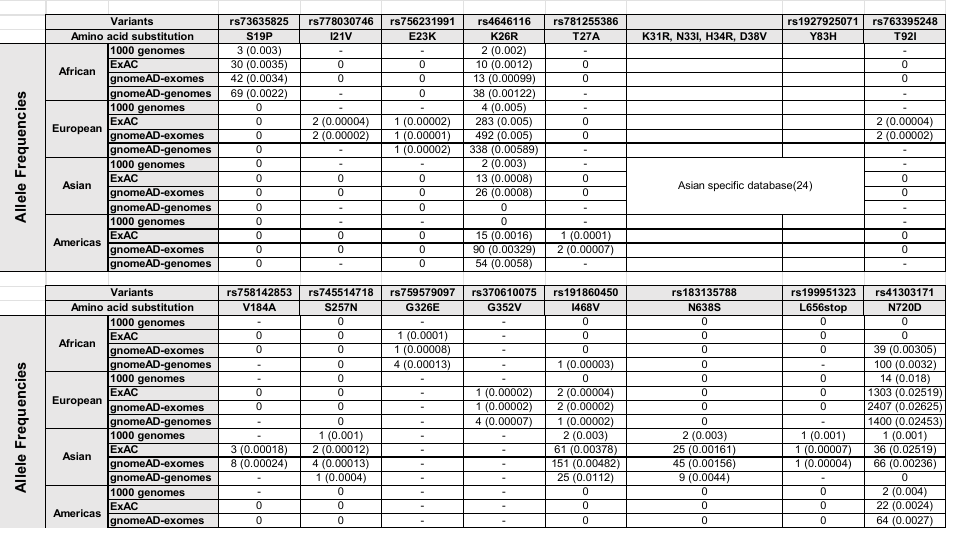
hACE2 genetic variants are named according to the amino acid substitution of the wild type hACE2. Identification numbers registered at the SNP database are listed. Data from the 1000 genomes, ExAC, gnomeAD-exomes, and gnomeAD-genomes were used. -, not found in that genome project. Minor allele counts (frequencies) are shown. These polymorphisms resulted in the following protein changes, S19P, I21V, E23K, K26R, K31R, T27A, N33I, H34R, D38V, Y83H, T92I, V184A, S257N, G326E, G352V,